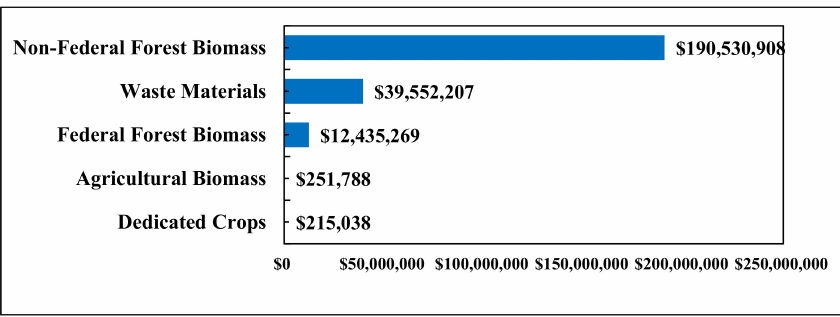
Figure 1. BCAP (Biomass Crop Assistance Program) matching payments allocation among eligible materials during 2009–2010. Data Source: The U.S. Department of Agriculture/Farm Service Agency, BCAP, 2010, Report of BCAP CHST (collection, harvest, storage and transportation) payments by biomass type [8].